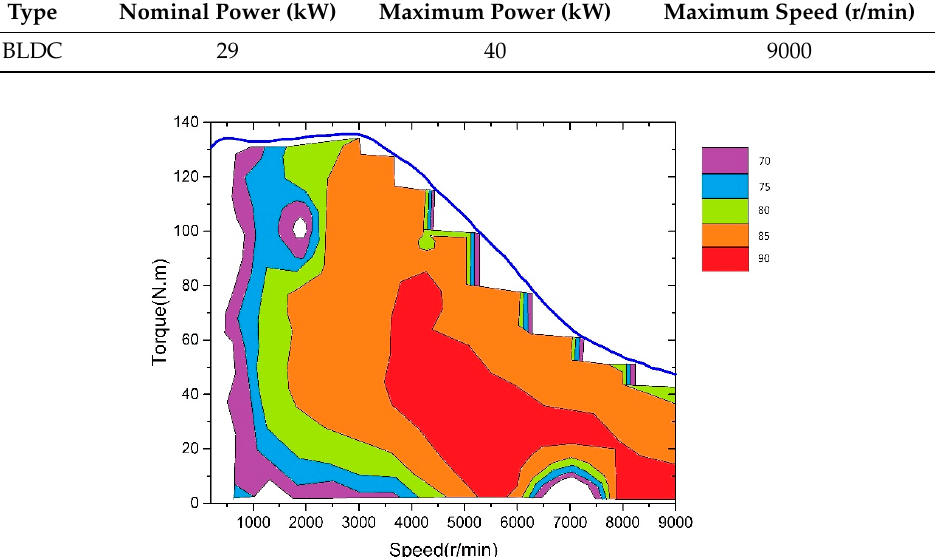
Table 5. Basic parameters of the electric motor. 174